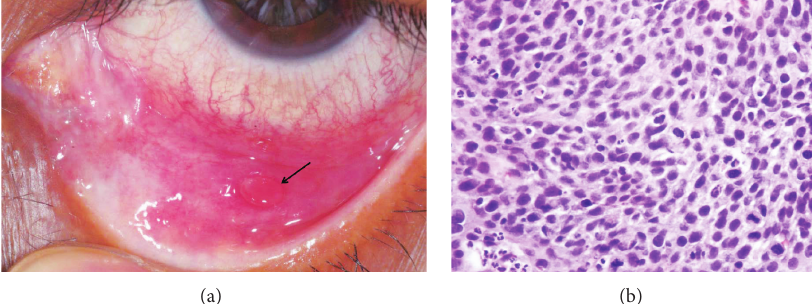
Figure 3: (a) Single pedunculated forniceal tumor is present, left lower lid (arrow). (b) dysplastic tumor cells admixed with inflammatory cells (hematoxylin/eosin (×400)